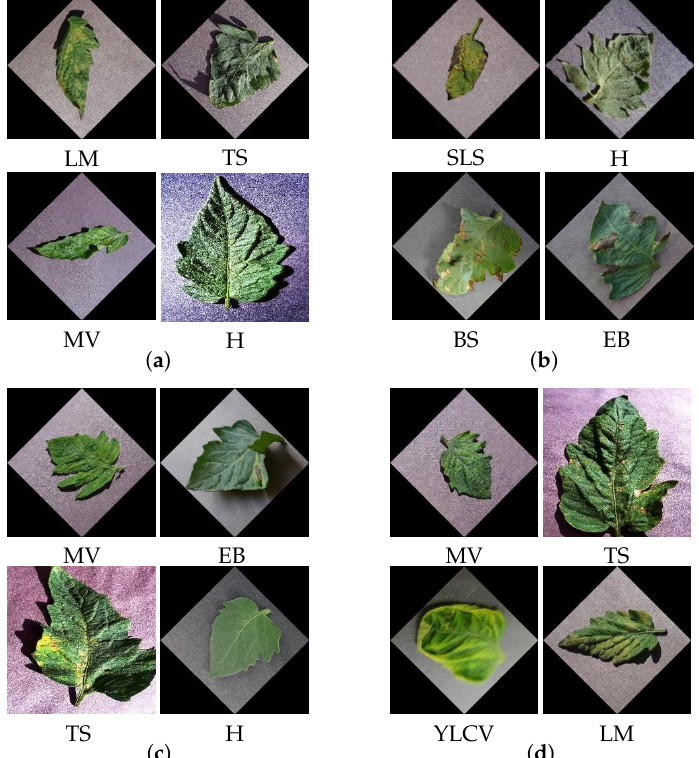
Figure 8. Output images after classification for 20% testing data using ( a ) N1, ( b ) N2, ( c ) N3, ( d )